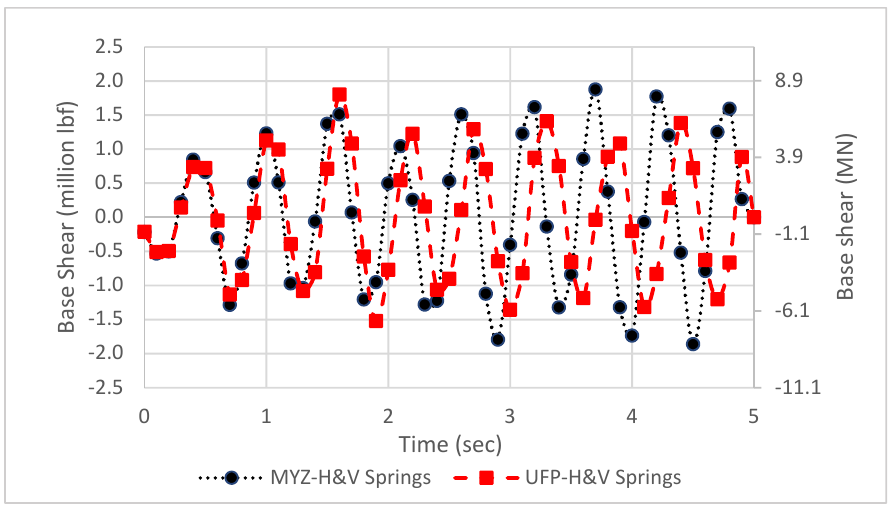
Figure 25. Base shear for MYZ and UFP connectors in building models with horizontal and vertical springs.